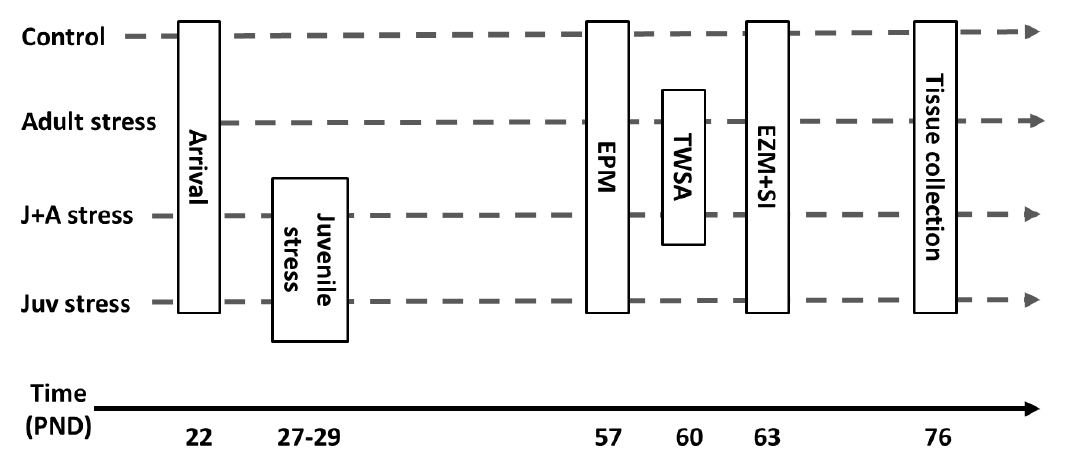
Figure 6. Experimental design.